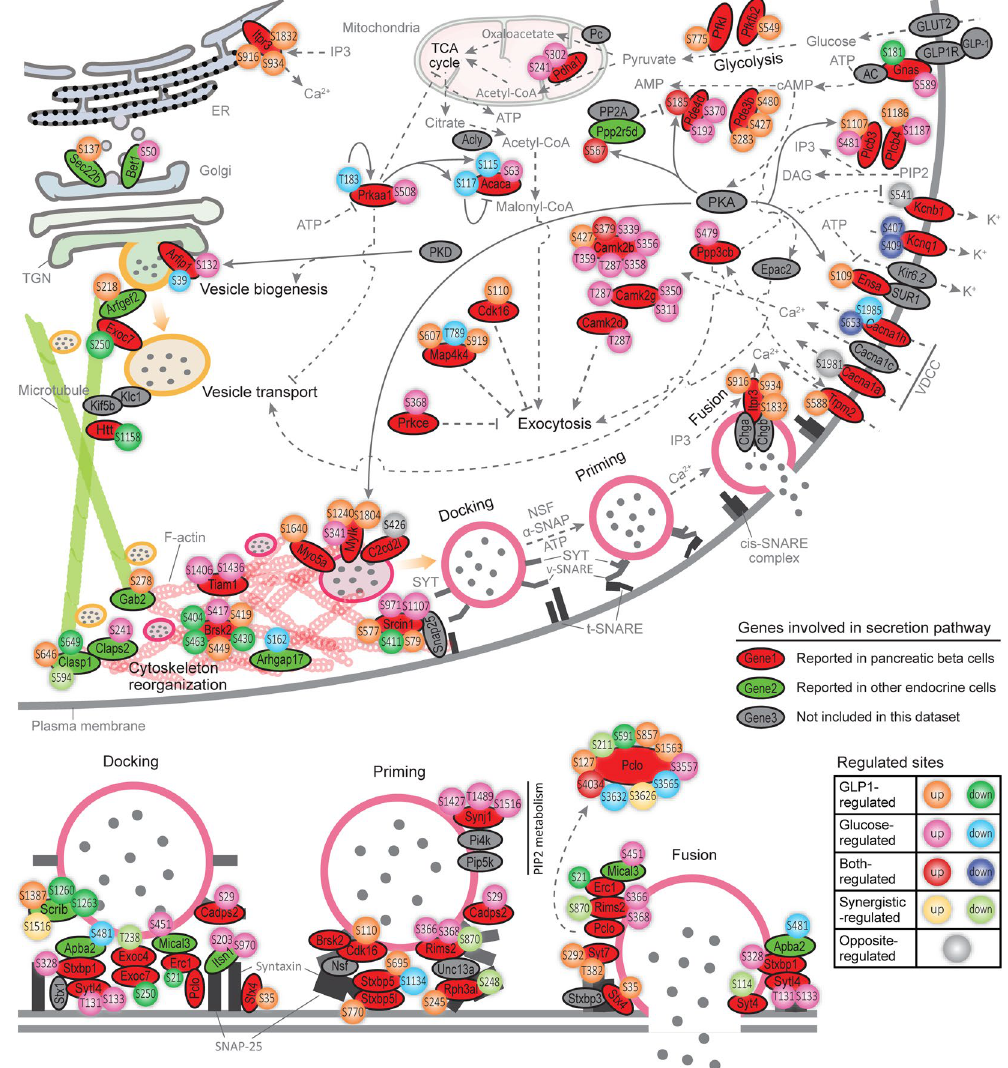
Figure 5. Synergistic regulation of secretion pathway. Regulated proteins annotated by GO database matching the biological process terms “insulin secretion” or “exocytosis” were presented to clarify the synergistic effect mediated by glucose and GLP-1 in secretion pathway. Only proteins with phosphorylation sites regulated by GLP-1 (LGLP1), glucose (HGlc) or their synergism (HGLP1) with high confidence were taken into count. The regulated sites were color-coded according to different regulation pattern as defined in Fig. 1G. Sold line means reported kinase-substrate